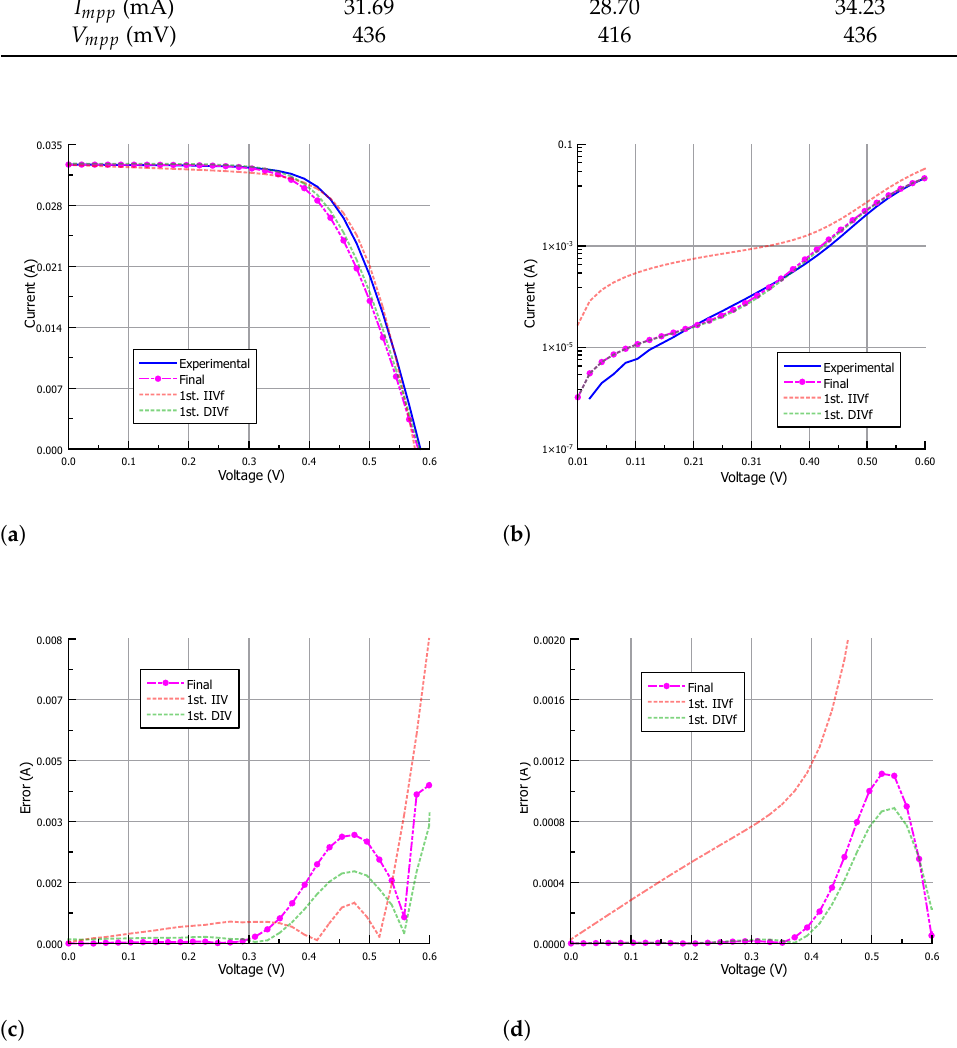
Figure 9. The I-V characteristic approximation of Cell-2 ( a ) under illumination and ( b ) in the dark; and corresponding absolute error ( c ) under illumination and ( d ) in the dark. Results are shown for parameters obtained after the first IIVf subroutine, after the first DIVf subroutine, and at the end of the parameter extraction